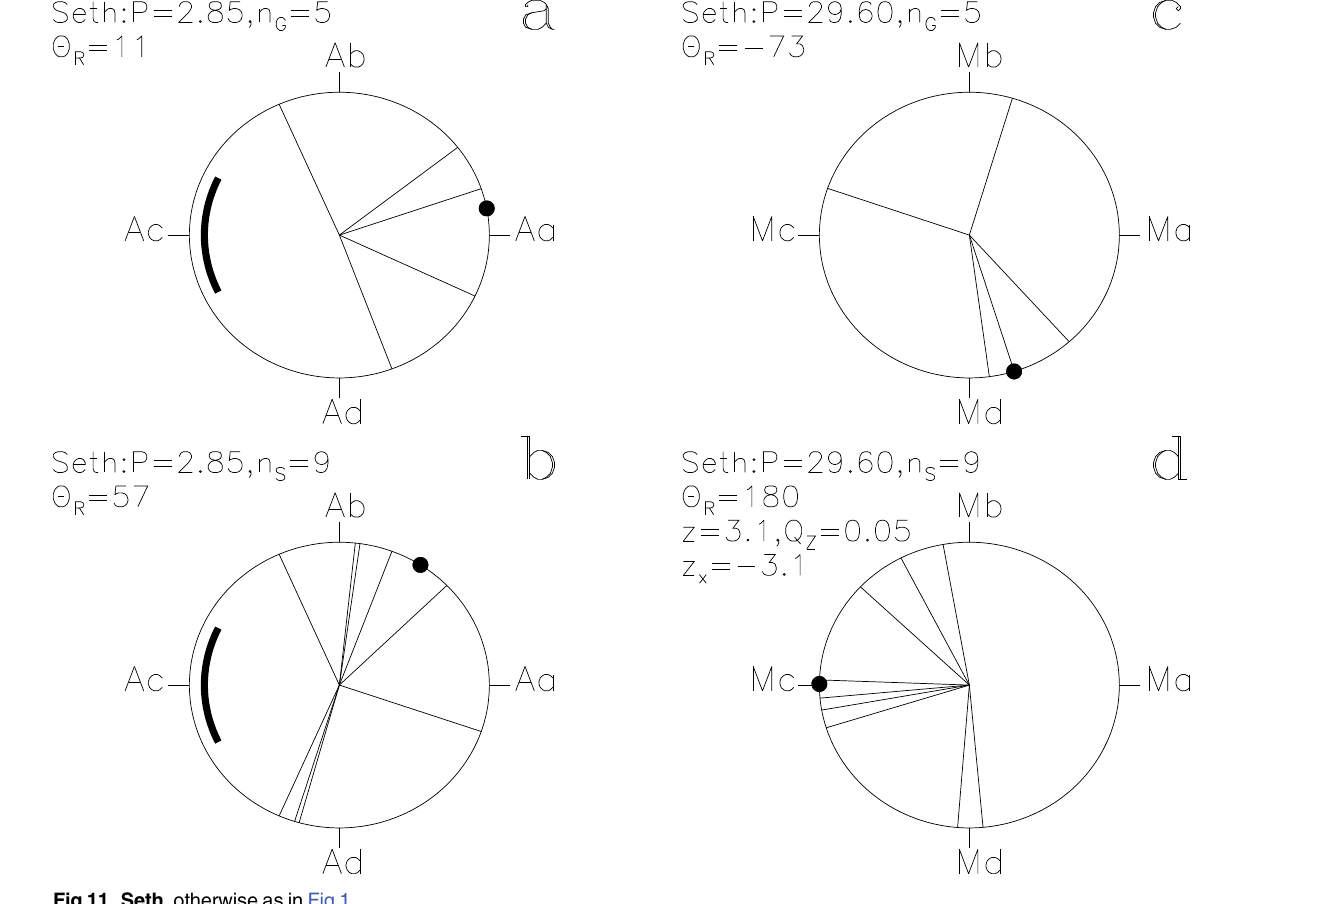
Fig 11. Seth. otherwise as in Fig